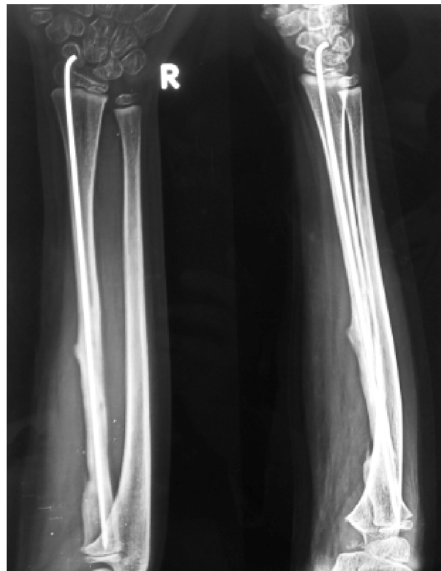
Figure 8. Six months follow-up X-ray showing incorporated graft with K-wire in situ after which the K-wire was removed.